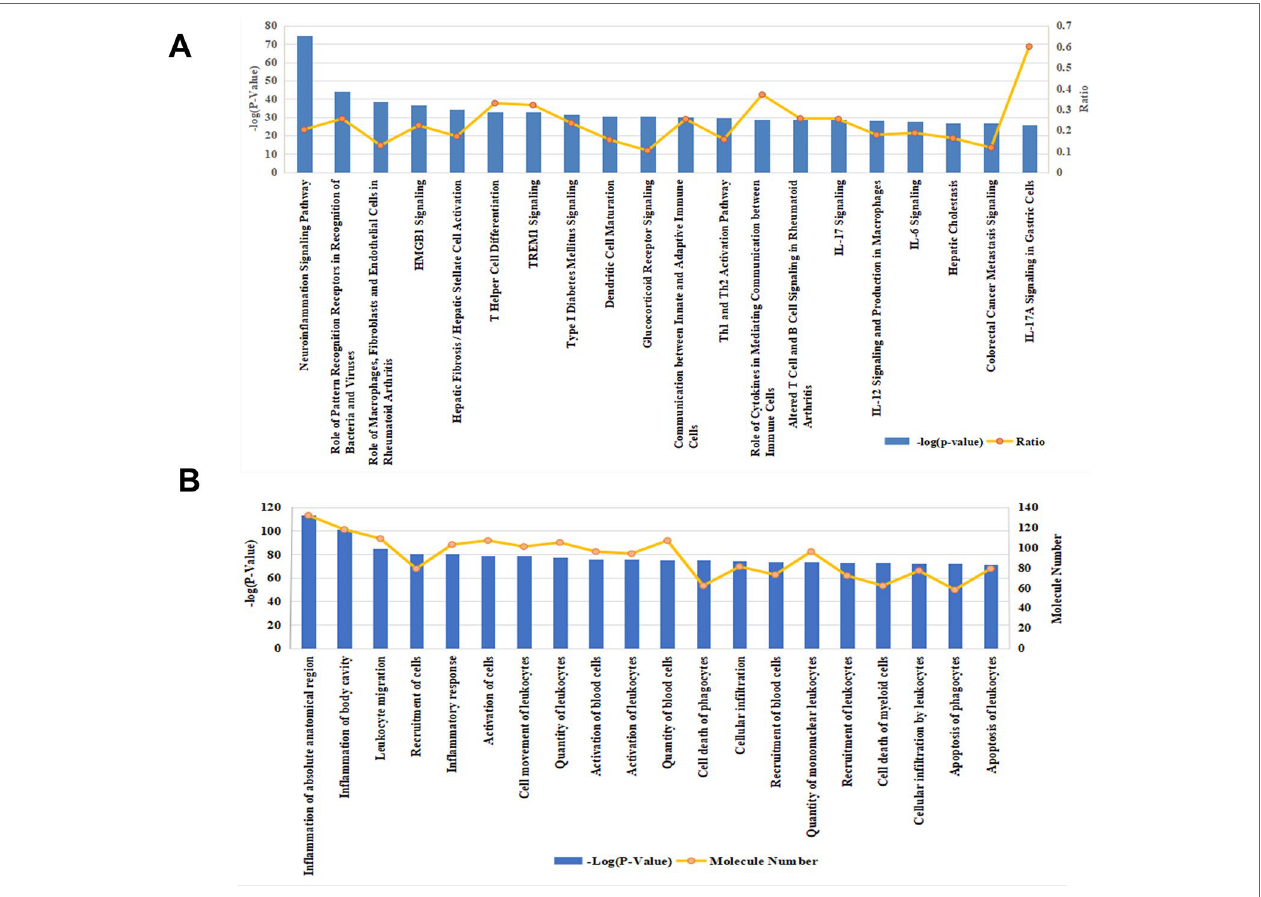
FIGURE 2 | Functional analysis and pathway analysis of 170 potential therapeutic targets in fungal infection. (a) The top 20 related pathways among molecules relevant to fungal infection. (B) Functional analysis of the 170 fungal infection target proteins. The top 20 pathways/functions were ranked from left to right by –log ( P value) and the ratio (yellow line) referred to the proportion of 170 molecules in the respective